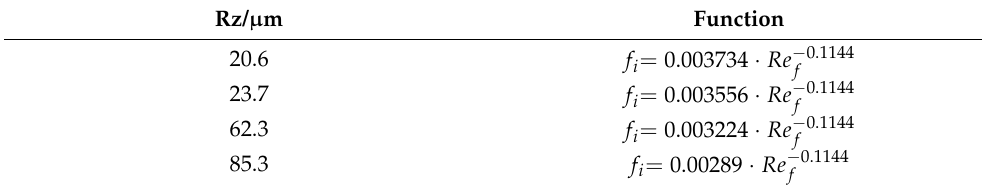
Table 2. Relational formula of interface shear coefficient under different